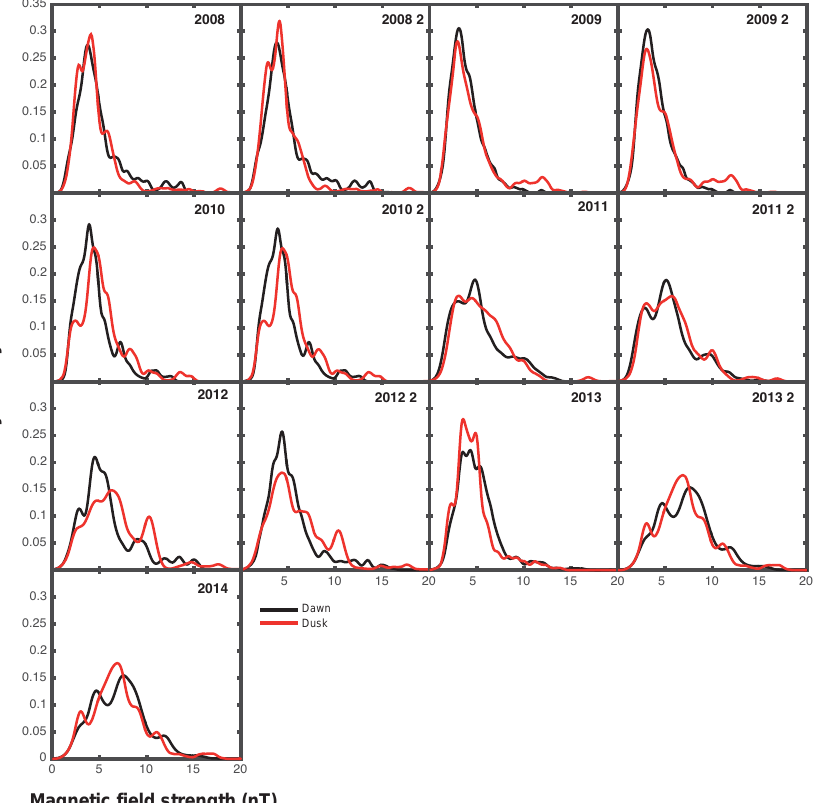
Figure B3. Yearly probability density functions of solar magnetic field strength ( | B | ) which correspond to magnetosheath data points on the dawn and dusk flanks. The “2” in each yearly label indicates that the data set spans the middle of that year to the middle of the next.